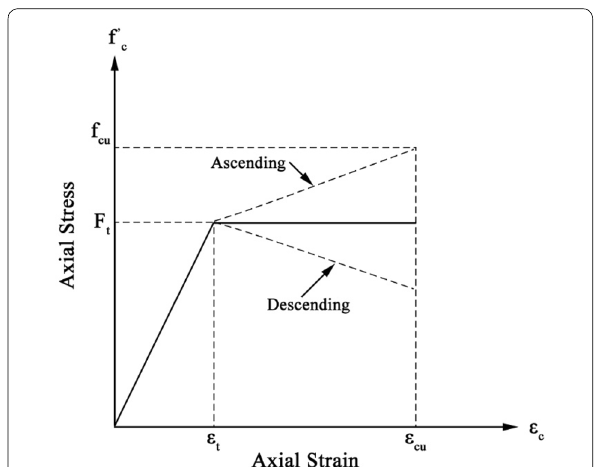
Fig. 1 Define of ascending and descending in Stress–strain